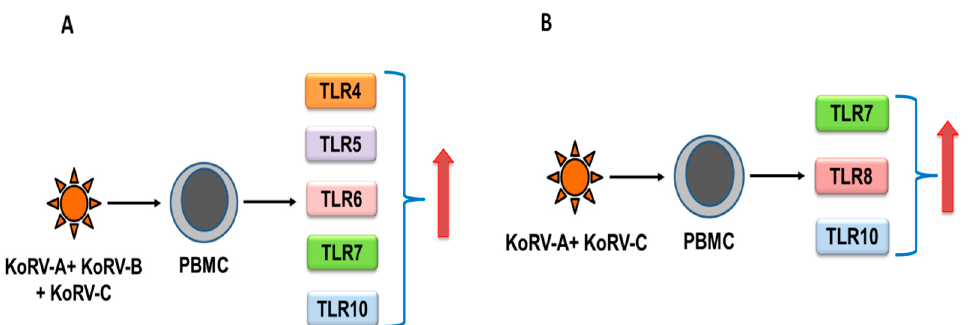
Figure 1. TLR response to infection with multiple KoRV subtypes in koalas (summarized from [77]). When compared with KoRV-A-infected koalas, upregulation was observed in TLR4-TLR7, and TLR10 mRNA in KoRV-A, KoRV-B, and KoRV-C-infected koala peripheral blood mononuclear cells (PBMCs) ( A ), and TLR7, TLR8, and TLR10 mRNA in KoRV-A and KoRV-C–infected koala PBMCs ( B ).